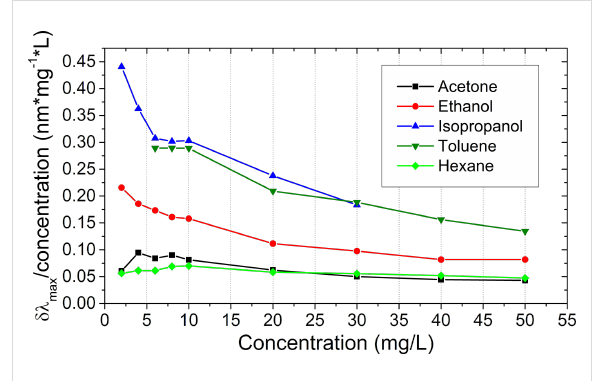
Figure 6: Optical response of the TiO 2 NP-based thin film towards dif- ferent VOCs (i.e., dependence of the shift of the reflection maximum on the VOC